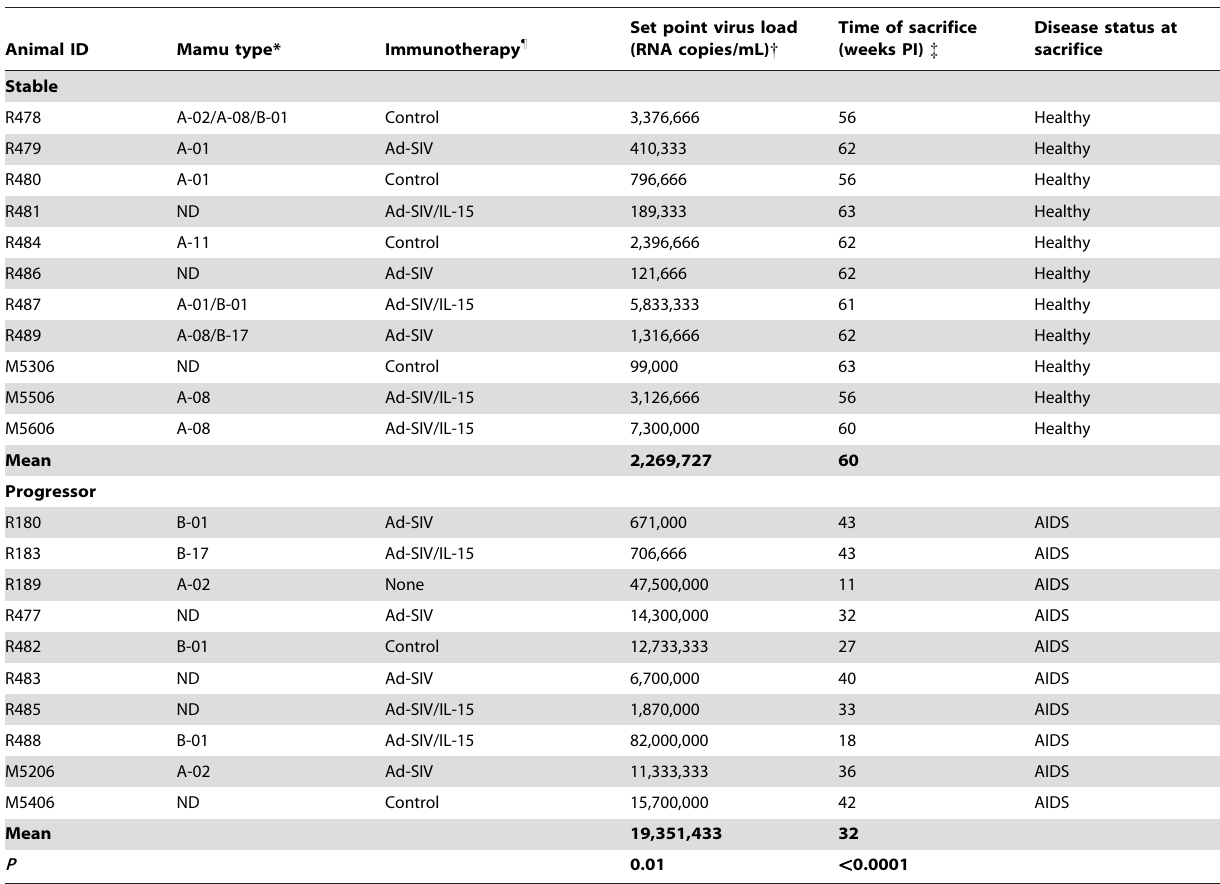
Table 1. Characteristics of animal